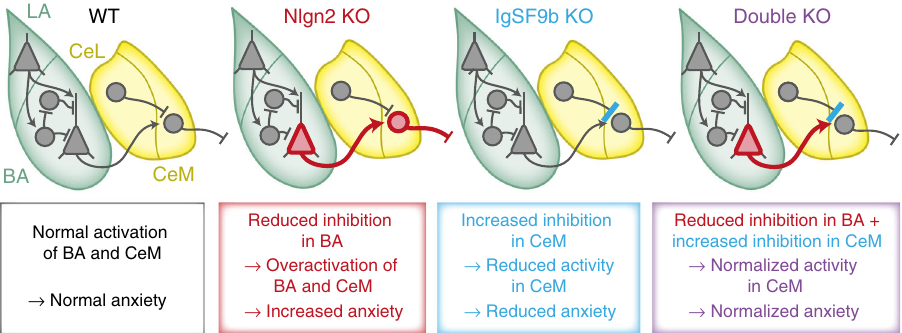
Fig. 8 Model of the circuitry-based normalization of the anxiety phenotype in Nlgn2 x IgSF9b double KO mice. Based on our fi ndings, we propose the following model for the normalization of anxiety-related behaviors in Nlgn2 x IgSF9b double KO mice: Nlgn2 deletion enhances activity of excitatory BA → CeM projection neurons, resulting in overactivation of anxiogenic projection neurons in the CeM and hence increased anxiety-related behaviors. IgSF9b deletion enhances synaptic inhibition onto anxiogenic projection neurons in the CeM, which results in reduced activation of CeM projection neurons and hence reduced anxiety-related behaviors. In Nlgn2 x IgSF9b double KO mice, the combination of these two effects results in normalization of the activity of CeM projection neurons and hence a normalization of anxiety-related